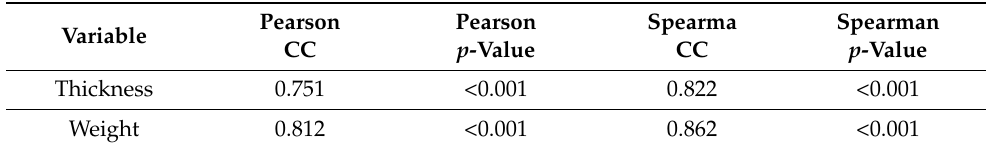
Table 3. Correlation of thickness and weight of the specimens with the failure loads among the groups.